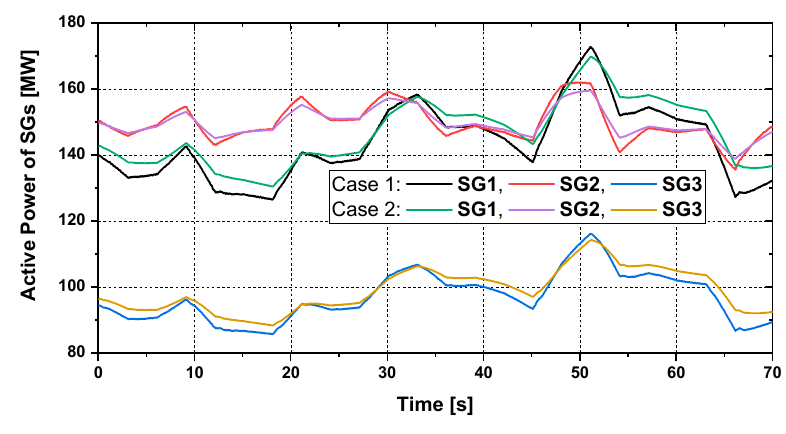
Figure 20. Hybrid power system frequency response.